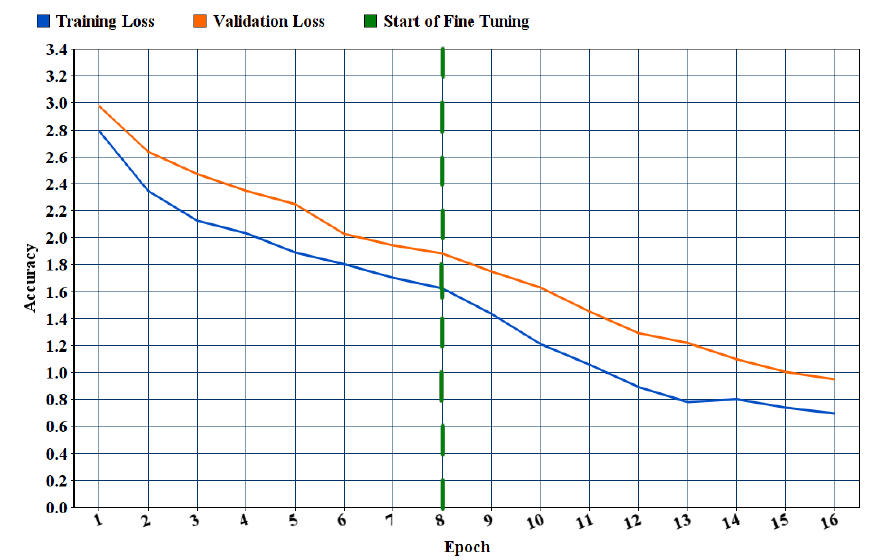
Figure 13. Mask R-CNN training model using COCO weights. During the first 8 epochs, only the semantic layer was trained. During the final 8 epochs, the entire model is